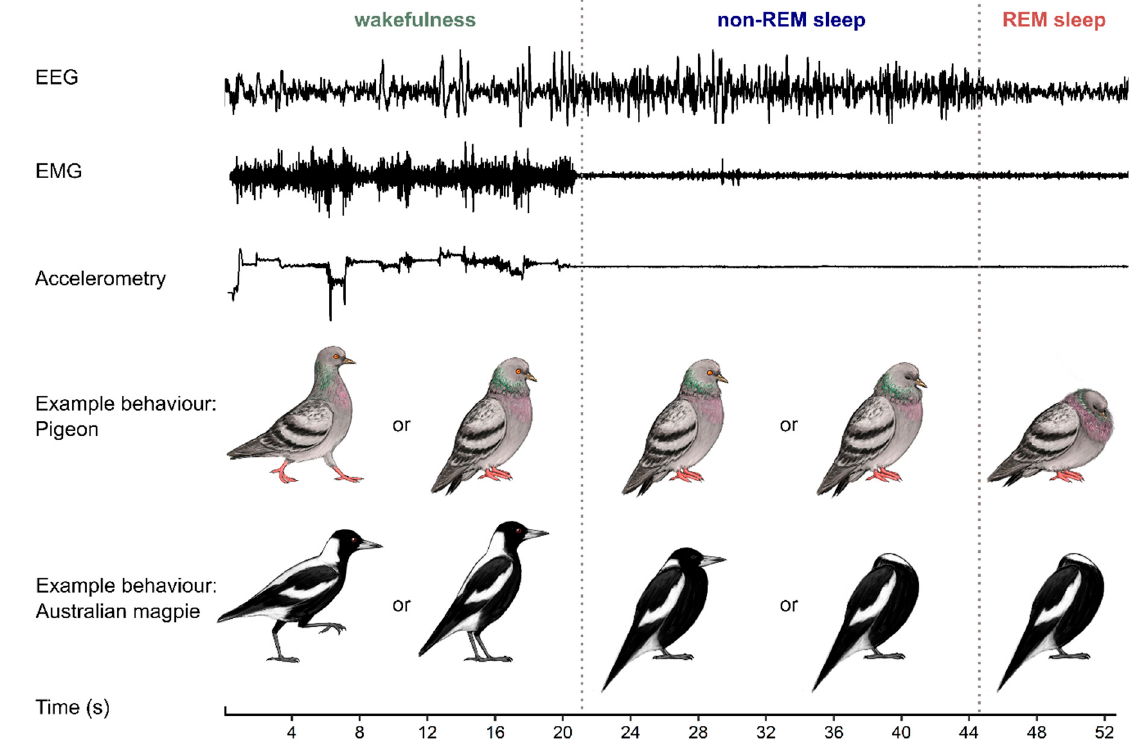
Figure 1. Birds can quickly transition between states of wakefulness, non-rapid eye movement (non-REM) sleep and REM sleep. When birds are awake, the electroencephalogram (EEG) is activated, muscle tone is typically high and variable (shown by the electromyogram or EMG), and the bird is often moving (shown by recordings of accelerometry or video). Non-REM sleep is characterized by slow (< 4 Hz) large waves in the EEG, typically accompanied by relaxed skeletal musculature and quiescent behavior; many birds (including pigeons) can also have one or both eyes open. REM sleep is characterized by wake-like patterns in the EEG, often (but not always) relaxed skeletal musculature from the preceding non-REM sleep level, eye movements behind closed eyelids and behavioral restfulness. As illustrated by the example postures of pigeons and Australian magpies, behavior can give some insights into a bird’s state, but it can be difficult to distinguish between sleep states or even between sleep and wakefulness [42]. These EEG, EMG and accelerometry traces are representative examples recorded from an Australian magpie. Illustrations by Laura X. Tan.